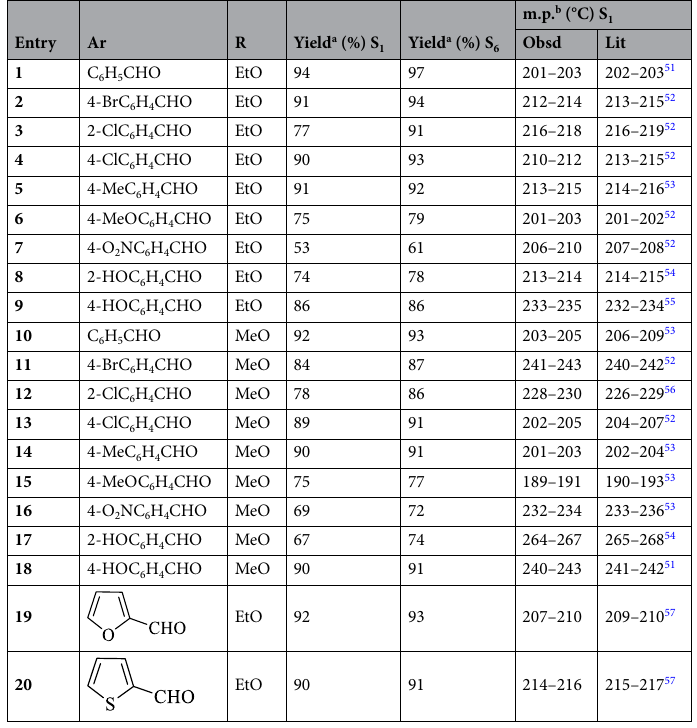
Table 6. Catalytic performance of S 1 and S 6 at optimum conditions. a Yield refers to isolated pure products. b Products were characterized by comparison of melting points with the known products reported in the literature.